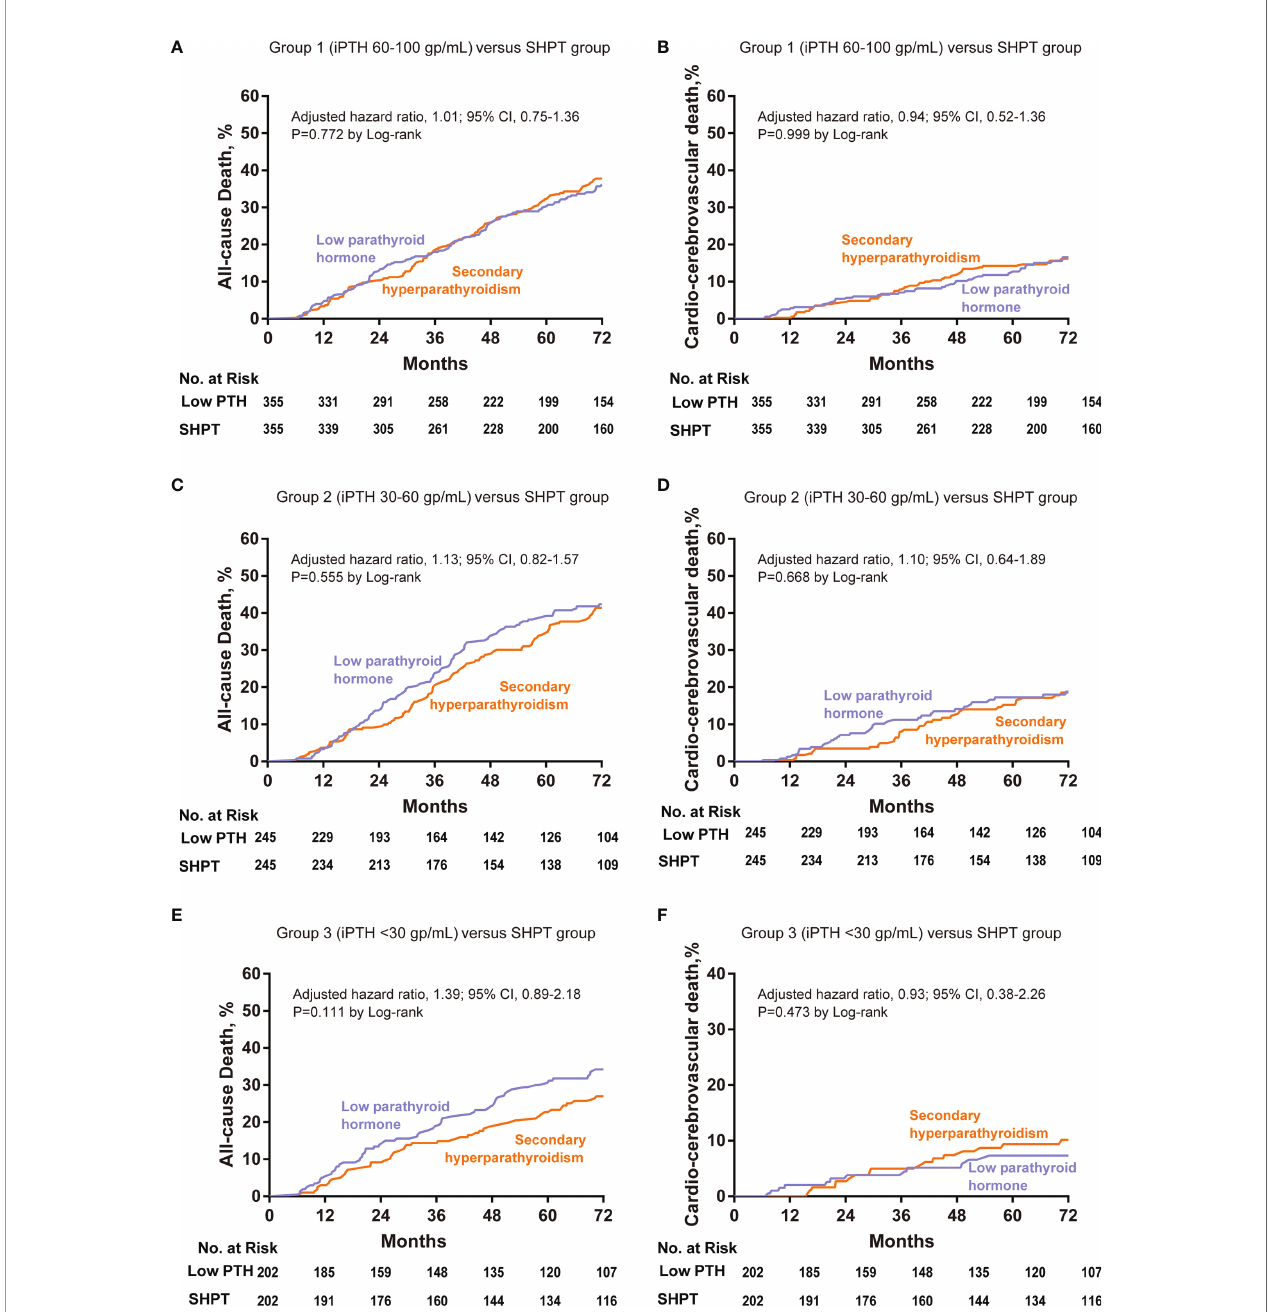
FIGURE 3 | Cumulative event rates at 72 months for all-cause death and cardio-cerebrovascular death among patients with low PTH and SHPT in the propensity- matched cohorts. Low PTH group 1 (60 – 100 pg/mL) versus the SHPT group, all-cause death (A) and cardio-cerebrovascular death (B) . Low PTH group 2 (30 – 60 pg/ mL) versus the SHPT group, all-cause death (C) and cardio-cerebrovascular death (D) . Low PTH group 2 (<30 pg/mL) versus the SHPT group, all-cause death (E) and cardio-cerebrovascular death (F) . Hazard ratios are based on multivariable Cox regression analyses. PTH, parathyroid hormone; SHPT, secondary